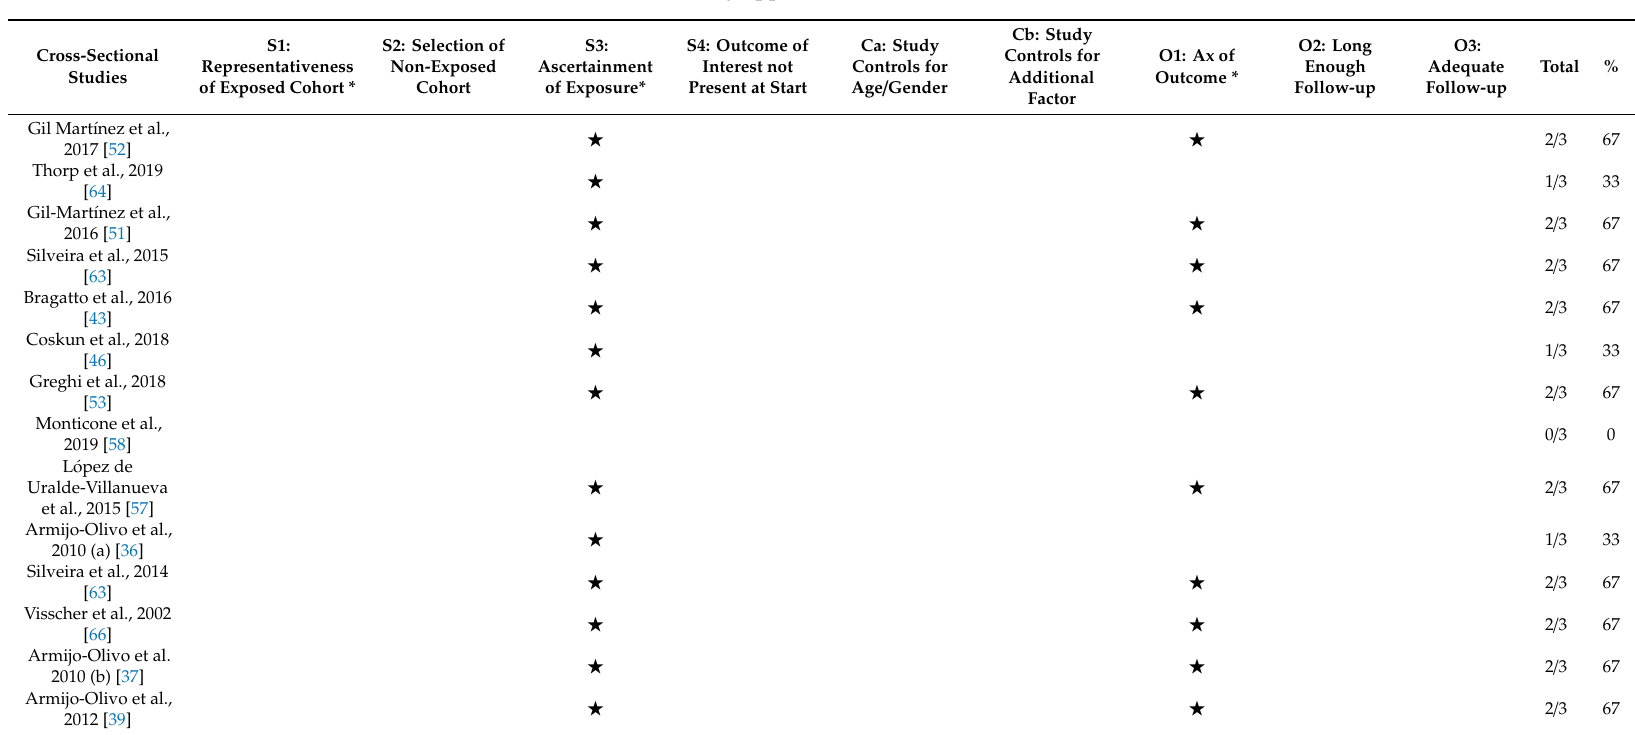
Table 3. Quality appraisal cross-sectional